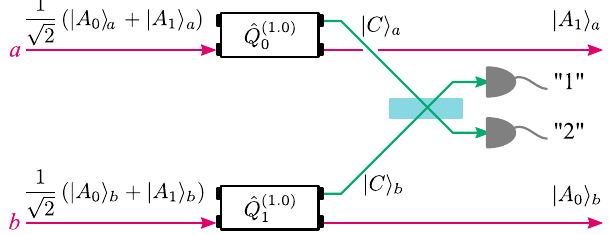
FIG. 13. Two TM qubits in spatial beams a and b can be fused with two QPGs, which select different “ red ” TM components from the qubits and selectively frequency convert them. Then, the “ green ” outputs of the QPGs are interfered at a 50 = 50 beam splitter (blue rectangle) and detected with detectors 1 and 2. For more information, see the